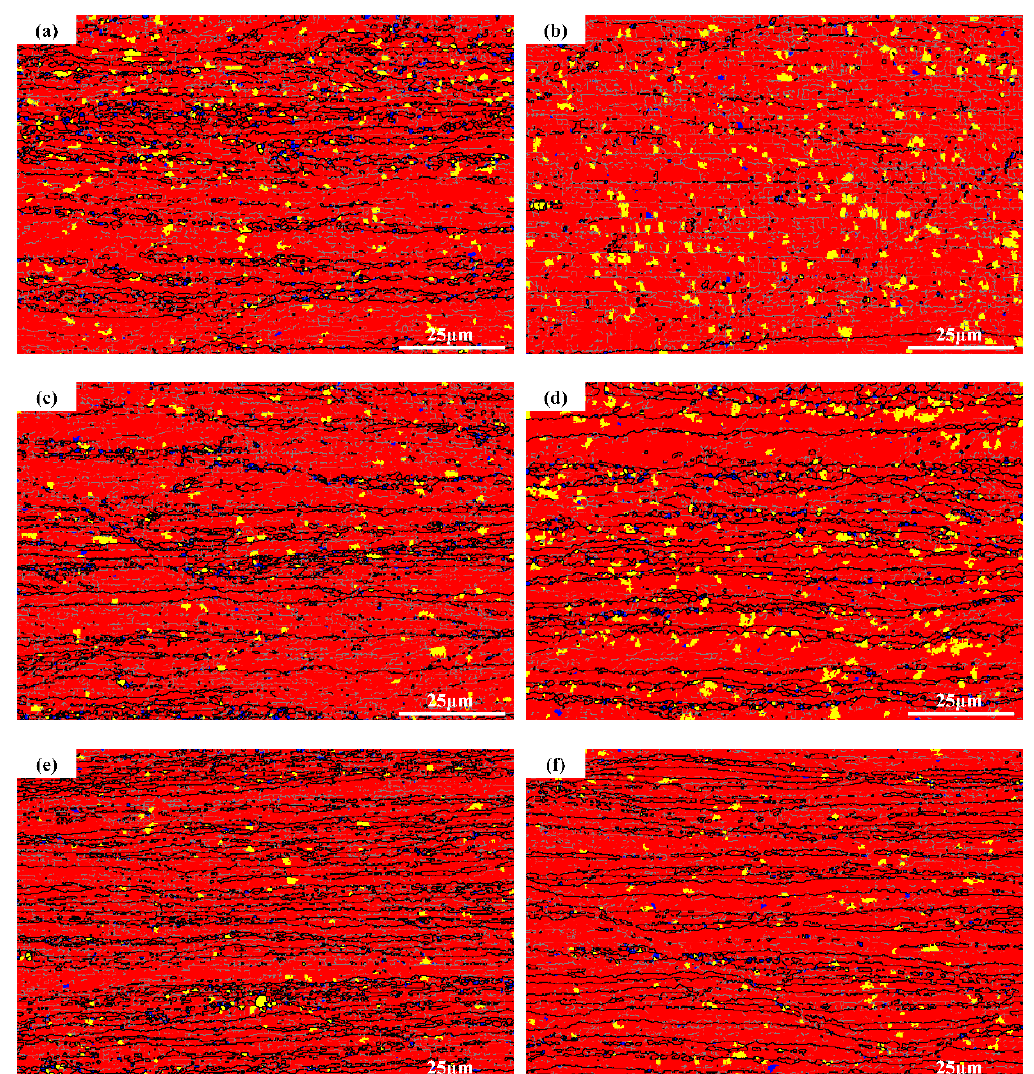
Figure 3 is a recrystallized region distribution map of a cold rolled alloy. The blue region represents recrystallized grains, the red regions represent deformed grains, and the yellow regions represent substructures. The frequency of the three different types of grains is plotted in Figure 4. After the cold-rolled alloy is deformed by 90% deformation, the grain type is mainly the deformation grain (frequency greater than 90%) of the small-angle grain boundary, and there are also some deformation substructures and a small amount of recrystallized grains. The recrystallization of the cold rolled alloy is due to the statistical error of the analytical software and the friction between the rolls and the sheet during rolling, and the heat generated causes partial recrystallization of the alloy.